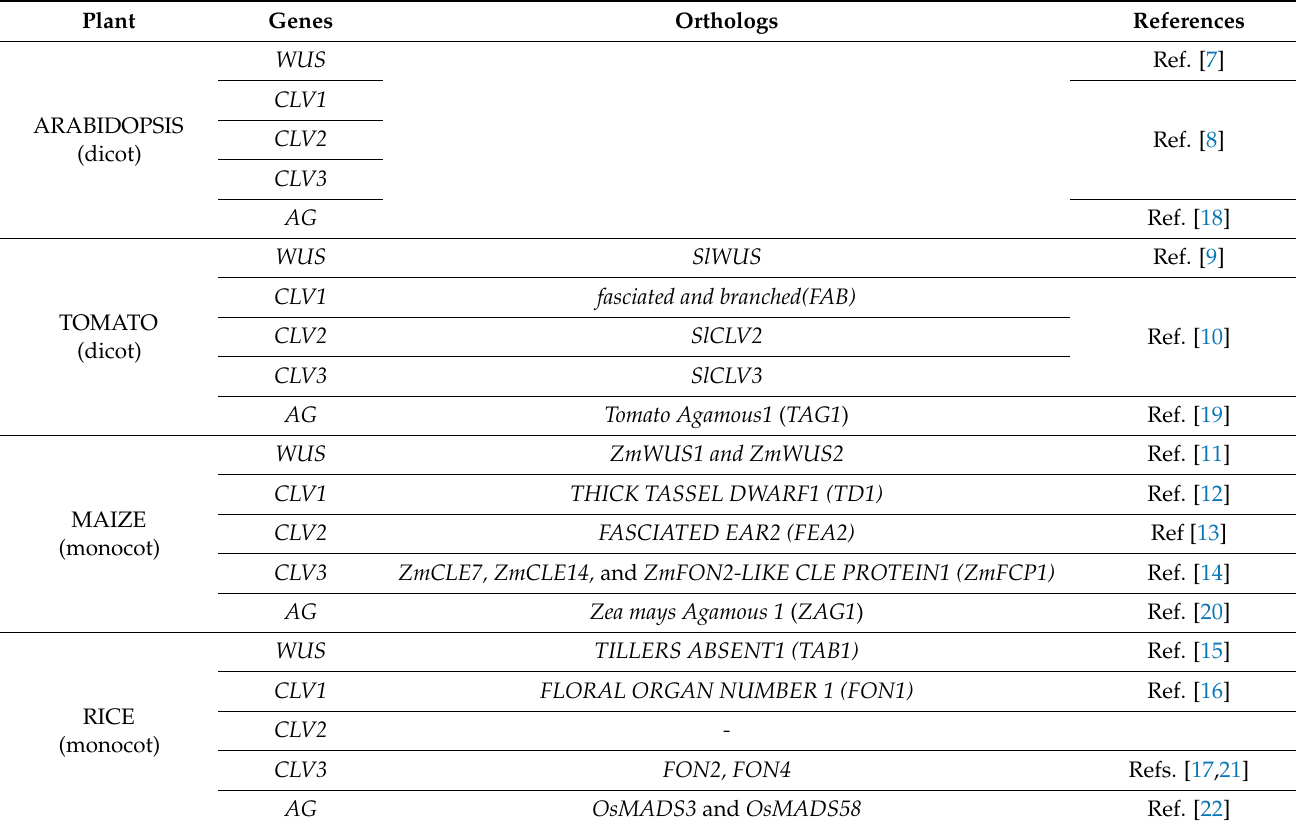
Table 1. WUS, CLV, and AGAMOUS (AG) orthologs in tomato, maize and